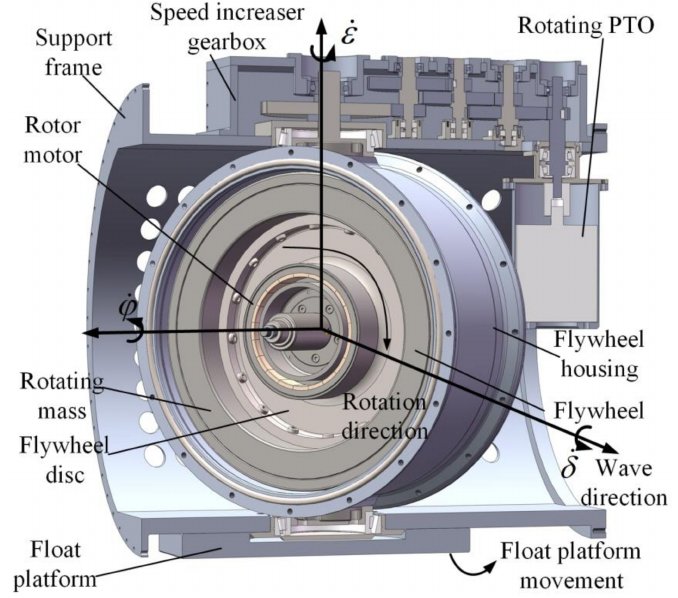
Figure 3. GWEC mechanical appearance.